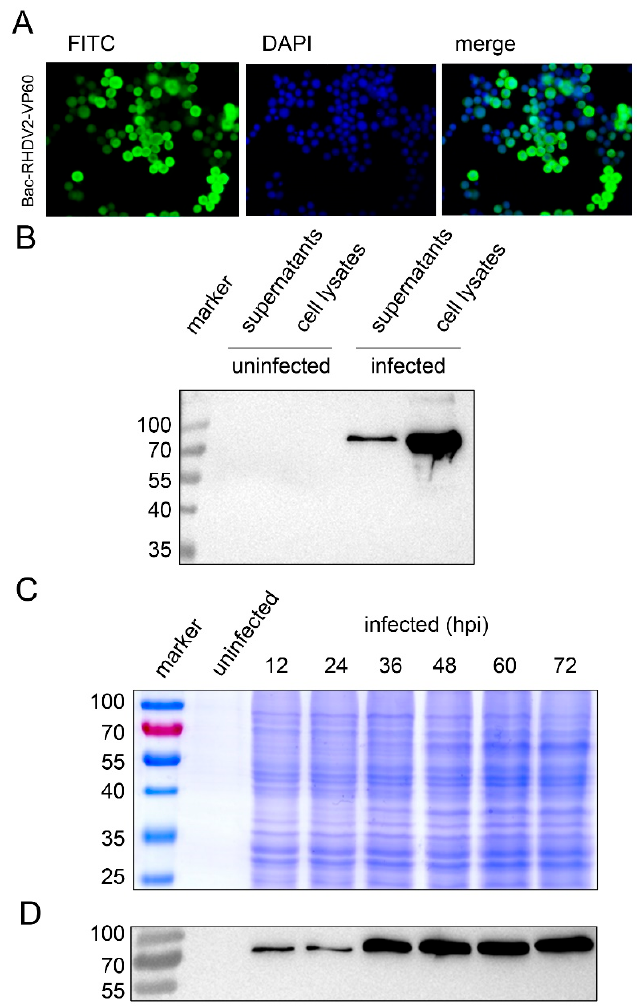
Figure 2. VP60 synthesis by infection of Sf9 cells with a recombinant baculovirus. ( A ) Indirect immunofluorescent assay to show the expression of His-VP60 in transfected Sf9 cells. Anti-His mAb was used as the primary antibody, and a FITC-conjugated rabbit-anti-mouse antibody was used for detection. DAPI was used to stain cell nuclei (200 × magnification). ( B ) Western blot (WB) analysis of